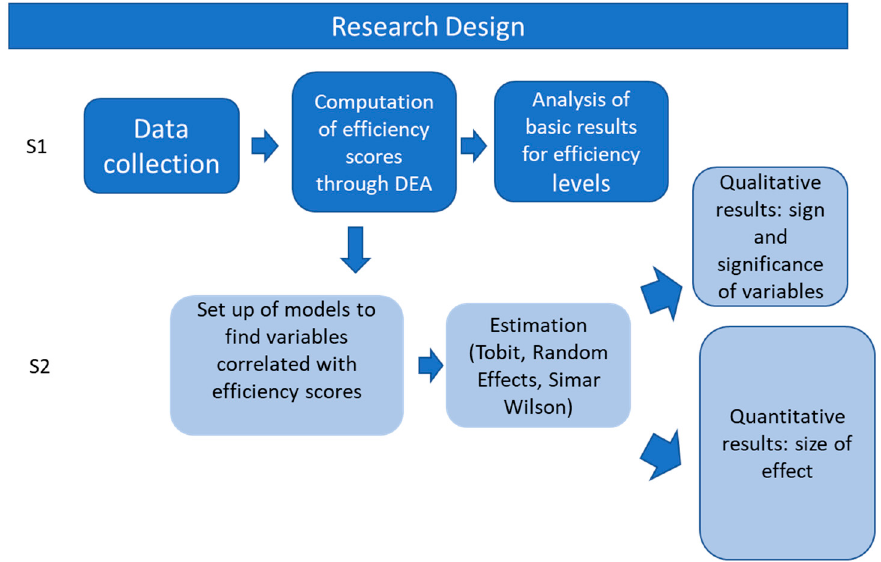
Figure A1. Explanatory diagram of our research design (S1 and S2 are Stage 1 and Stage 2).